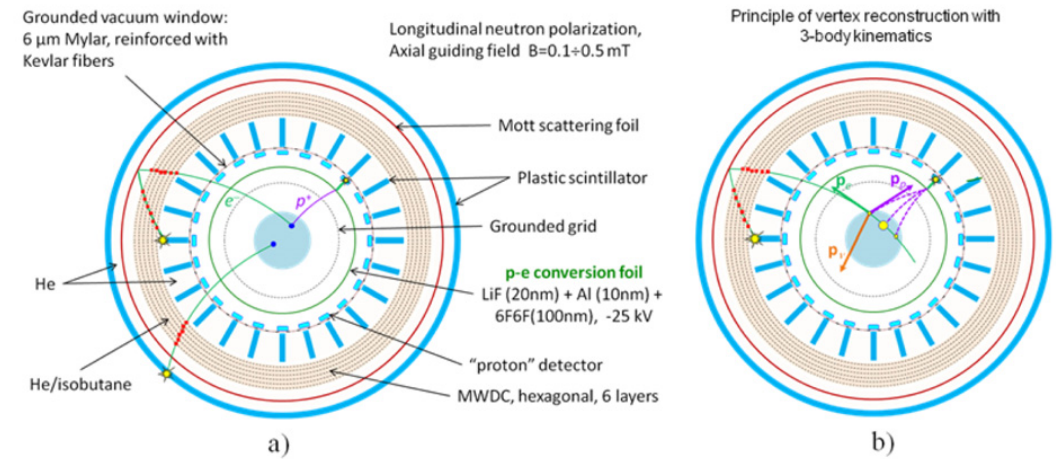
Figure 3. Sketch of the proposed experimental setup in the cylindrical geometry. a) Cross section perpendicular to the beam (and detector) axis. b) Illustration of the conditional reconstruction of the 3-body kinematics using the likelihood method. Size of the yellow dots represent the likelihood assigned to particular solutions which is proportional to the neutron decay density in the fiducial volume.